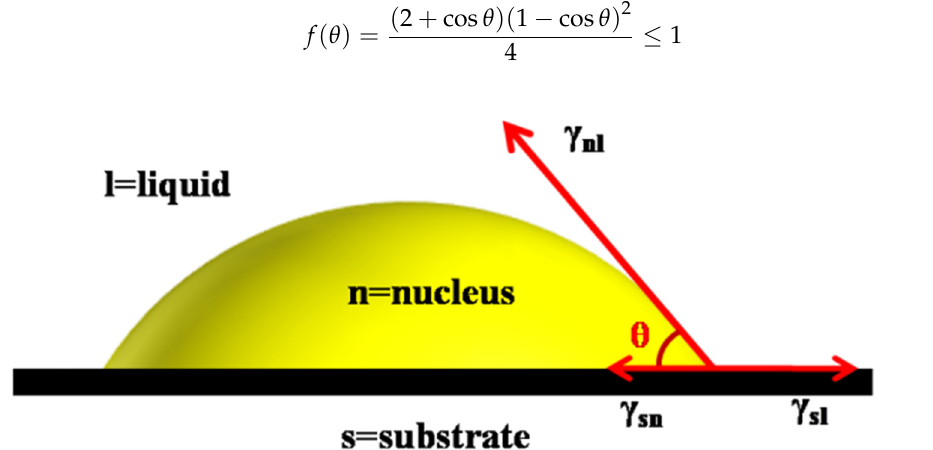
Figure 8. Cap-shaped model of inhomogeneous nucleation.